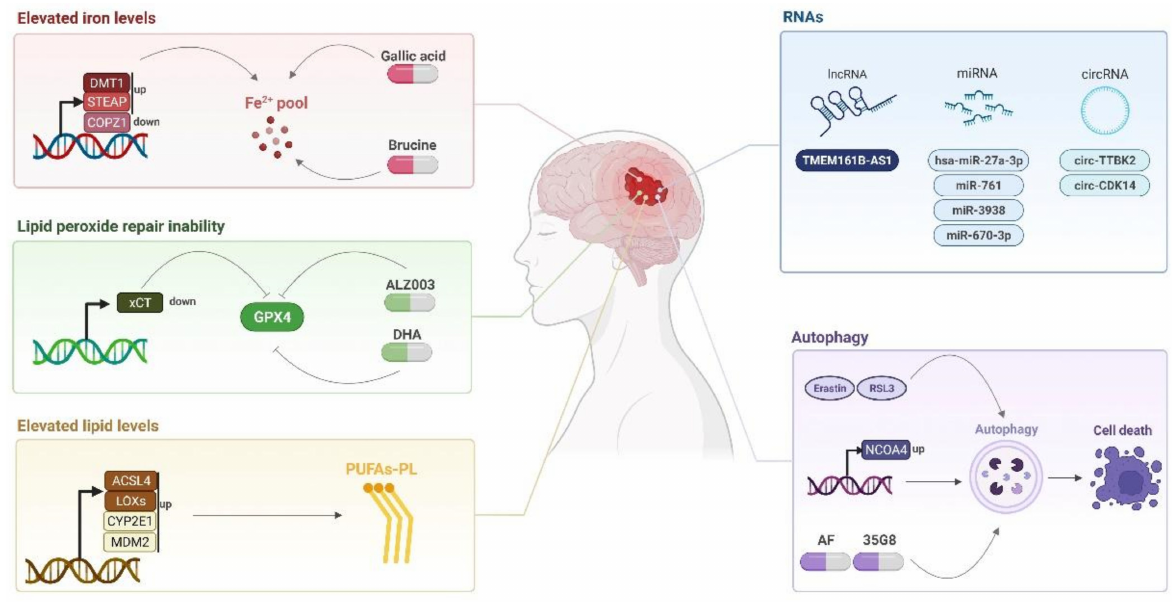
Figure 2. The schematic view of new potential targets for glioblastoma treatment by ferropto- sis modulation. The red box indicates the interesting new mechanisms for iron accumulation by the upregulation of DMT1 and STEAP genes, or by the downregulation of COPZ1 . Additionally, the administration of gallic acid and brucine could induce a labile iron pool, promoting ferrop- totic cell death in glioblastoma cells. Targeting GPX4 inhibition is also an interesting approach for glioblastoma treatment; this effect could be triggered by xCT downregulation, or by AZL003 and dihydroartemisinin (DHA) administration, as demonstrated in the green box. The yellow box shows that the PUFAs accumulation could be induced by the upregulation of several genes of lipid metabolism such as ACSL4 and LOXs , or by CYP2E1 and MDM2 upregulation. In the blue box is detailed that the regulation of lncRNA, circRNAs, and miRNAs could also be an interesting target for glioblastoma treatment. Finally, in the purple box, ferroptosis-inducers such as Erastin and RSL3, NCOA4 regulation, polyphenol amentoflavone (AF), and 35G8 administration promote autophagy induction, leading to ferroptotic cell death in glioma cells. Abbreviations: up: upregulation; down: downregulation. Created with